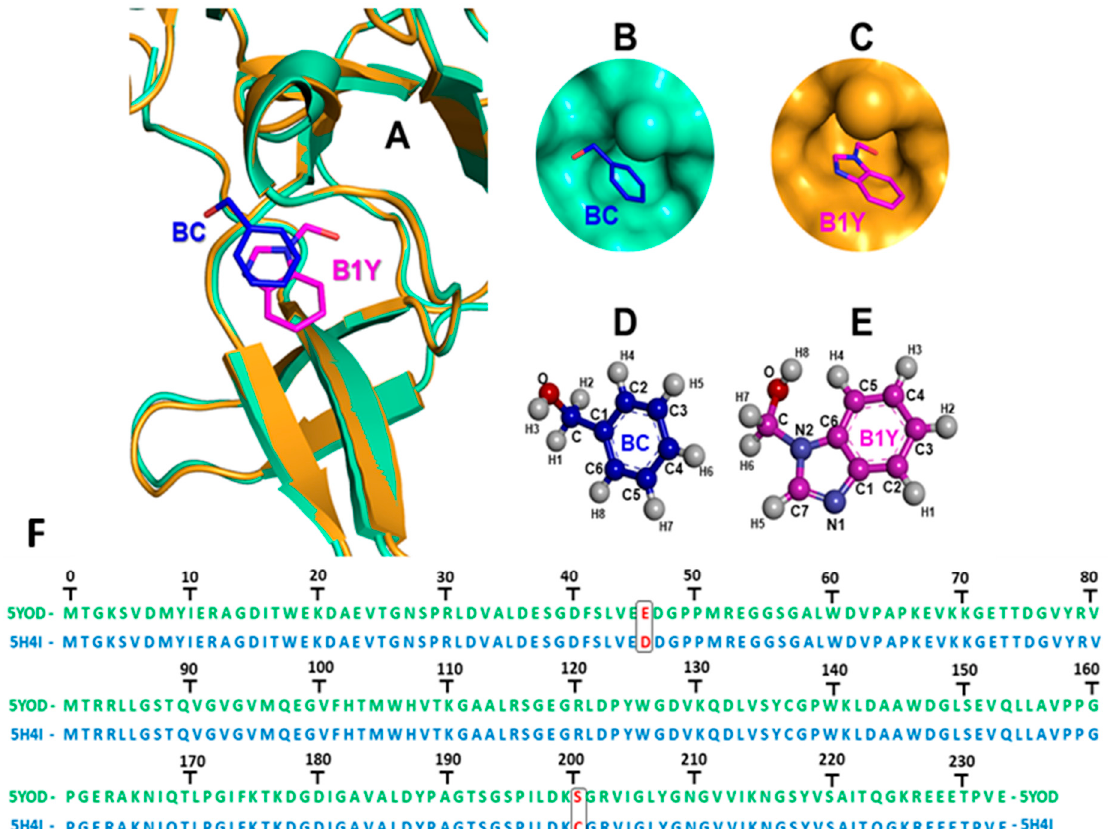
Figure 2. ( A ) Superimposition of the Zika virus protease co-crystallized with inhibitors benzoic acid (BC, 5YOD PDB file, emerald color) and benzimidazole-1-ylmethanol (B1Y, 5H4I PDB file, mustard color) at the active site; ( B ) BC in 5YOD; ( C ) B1Y in 5H4I; ( D , E ) 2D representation of BC and B1Y; ( F ) alignment of the viral proteases according to the 5YOD and 5H4I PDB files.